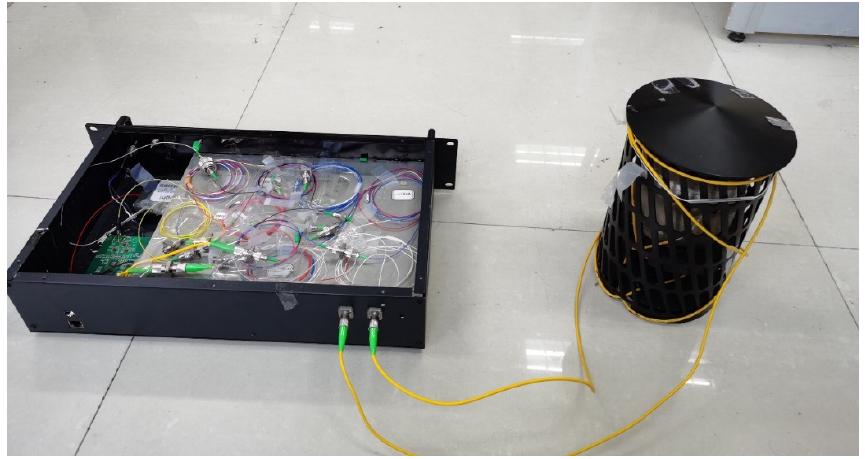
Figure 6. A photo of the testing system.